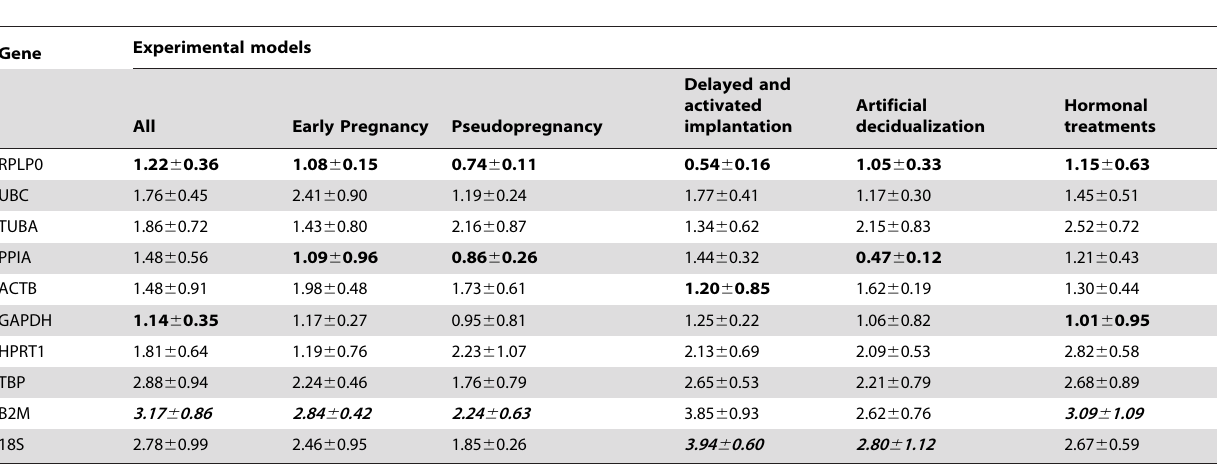
Table 4. Ranking of candidate reference genes in order of their expression stability as calculated by BestKeeper.